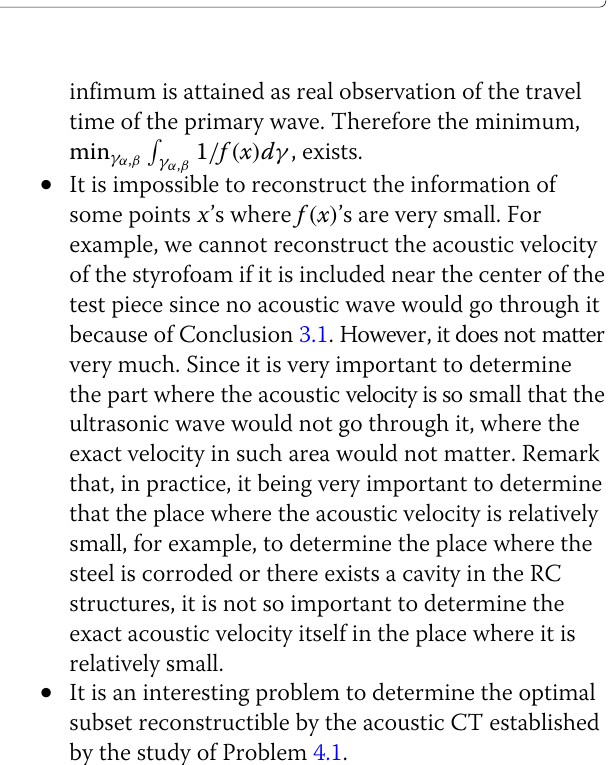
Fig. 7 Test pieces of mortar with styrofoam (age of 4 weeks)